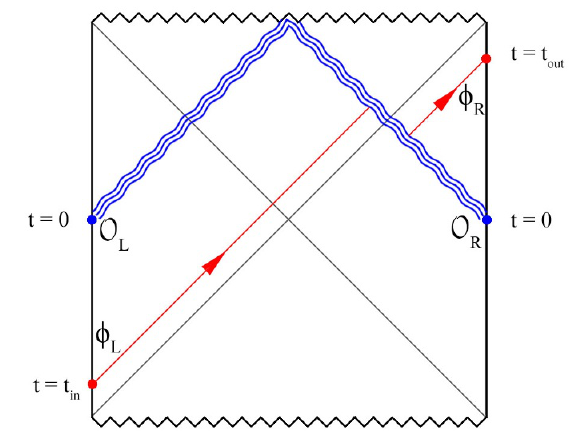
Figure 1 . A double trace deformation creates a shockwave which displaces the probe (cid:30) , allowing it to escape from the black hole. The coordinates are discontinues at the shockwave, while the path of the probe is